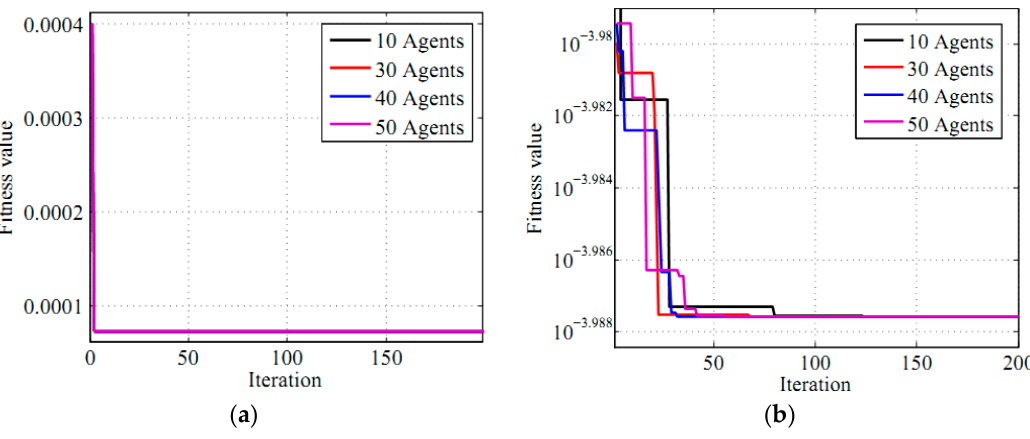
Figure 2. Convergence curve of antlion optimizer (ALO) algorithm for ( a ) IEEE 30-bus; ( b ) IEEE 118-bus. Table 4. Optimal parameters of SVR model found using ALO algorithm. Table 4. Optimal parameters of SVR model found using ALO